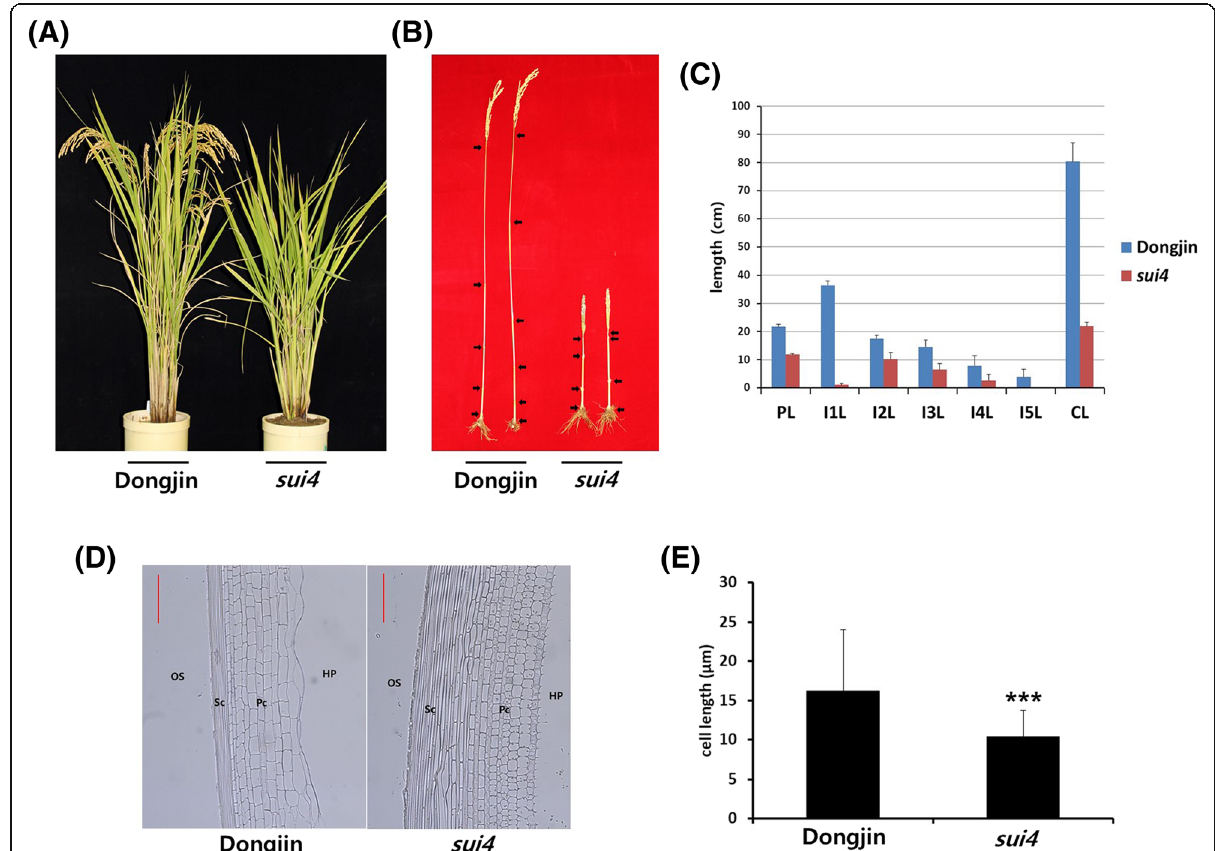
Fig. 1 Phenotype comparison between Dongjin plants and sui4 mutants. ( a ) Plant architecture at maturing stage. ( b ) Culm structure. Arrows indicate locations of nodes. Two main culms from two plants are shown for each phenotype. ( c ) Comparison of internode length between Dongjin plants and sui4 mutants. PL: panicle length, I1L: first internode length, I2L: second internode length, I3L: third internode length, I4L: fourth internode length, CL: culm length. ( d ) Longitudinal sections of the uppermost internodes of Dongjin plants and sui4 mutants. Red bars denote 50 μ m. HP: hollow pith, OS: outer space, Sc: sclerenchyma tissue, Pc: parenchyma tissue. ( e ) Cell length in the uppermost internodes of Dongjin plants and sui4 mutants. The lengths of cells in parenchyma tissues were measured. Data are shown as the mean ± s.d. (t-test, *** P < 0.001). The cells in three samples were measured for Dongjin plants and sui4 mutants,